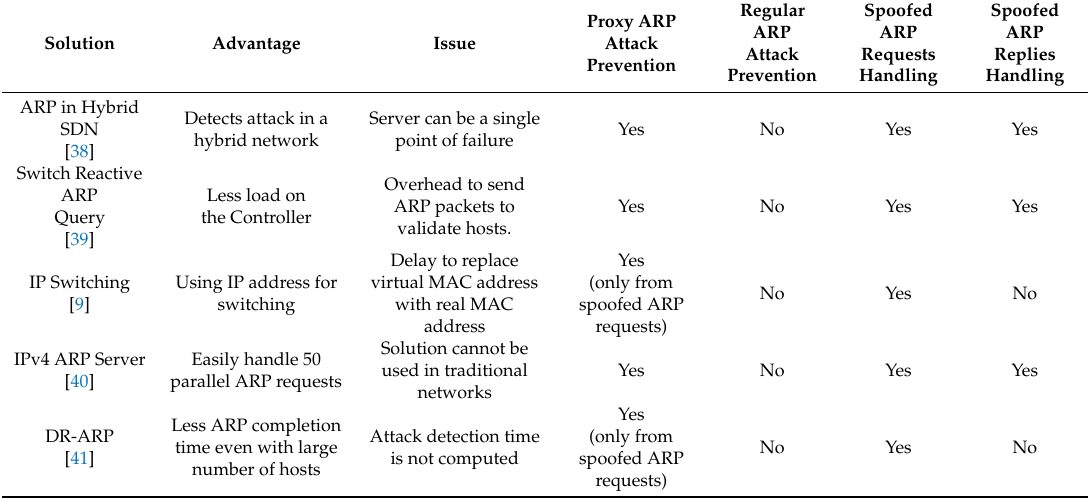
Table 4. Summary of IP-MAC Address Bindings on Other Network Elements Based